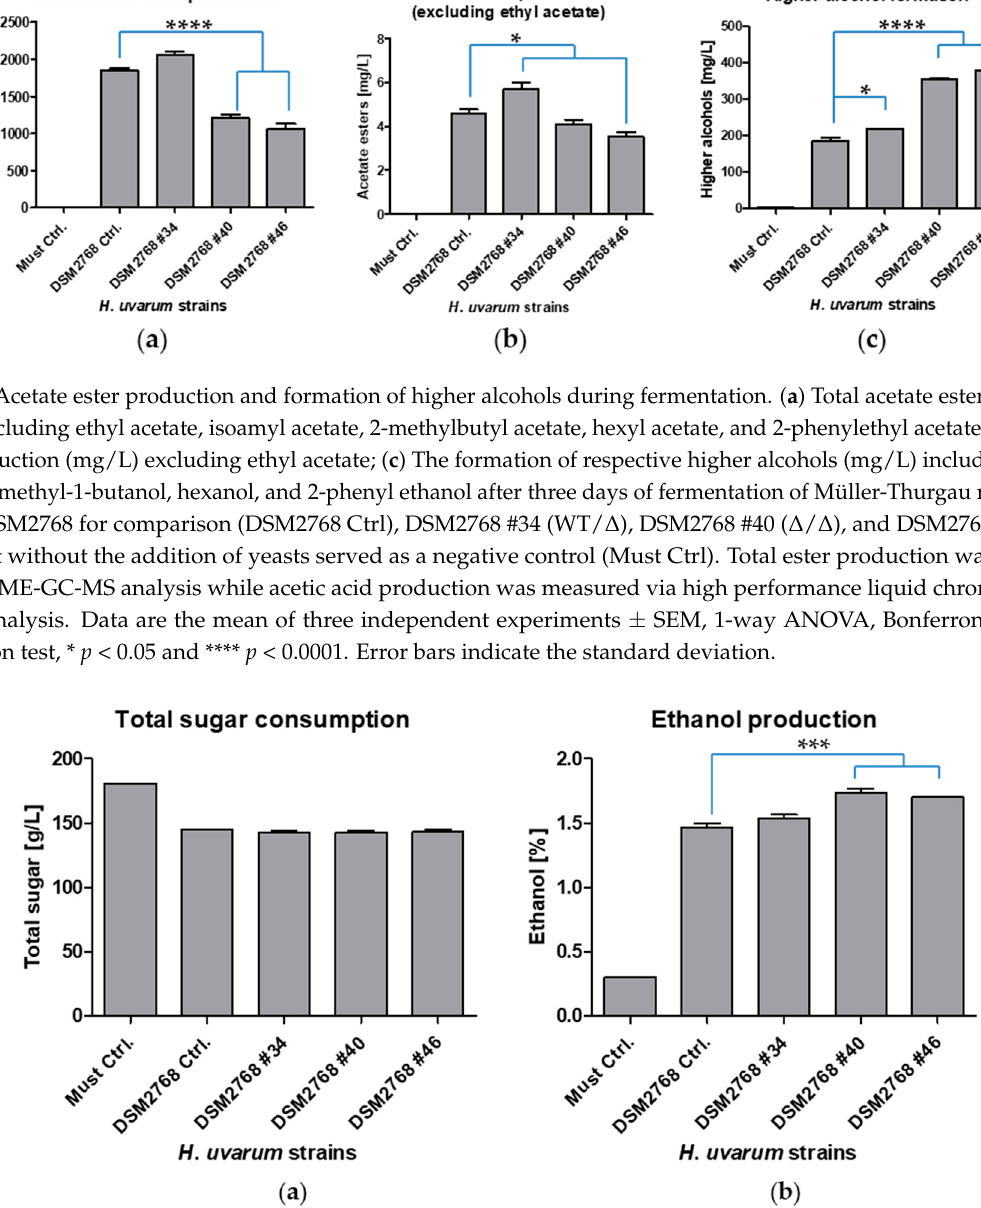
Figure 4. ( a ) Total sugar consumption (g/L); ( b ) Ethanol production (%) after three days of fermentation of Müller-Thurgau must with H . uvarum DSM2768 for comparison (DSM2768 Ctrl), DSM2768 #34 (WT/ ∆ ), DSM2768 #40 ( ∆ / ∆ ), and DSM2768 #46 ( ∆ / ∆ ). Pure must without the addition of yeasts served as a negative control (Must Ctrl). The amount of total sugar and ethanol produced was measured via high performance liquid chromatography (HPLC) analysis. Data are the mean of three independent experiments ± SEM, 1-way ANOVA, Bonferroni´s multiple comparison test, *** p < 0.001. Error bars indicate the standard deviation.